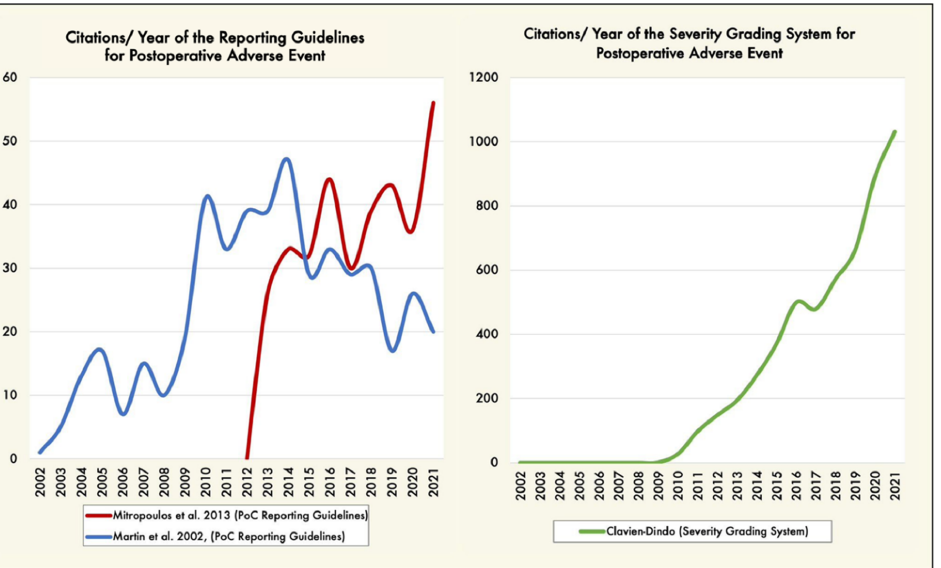
Figure 2. ( Left graphic ) Trends of articles citing the postoperative adverse event reporting guide- lines [7,9], by year (blue and red lines). ( Right graphic ) Trends of articles reporting postoperative complications severity grading system [10,11], by year (green line). Trends over time were per ‐ formed using the Web of Science citation database (https://tinyurl.com/3emtzjw8 accessed on 17 August 2022, date last accessed). PoC: postoperative complications.